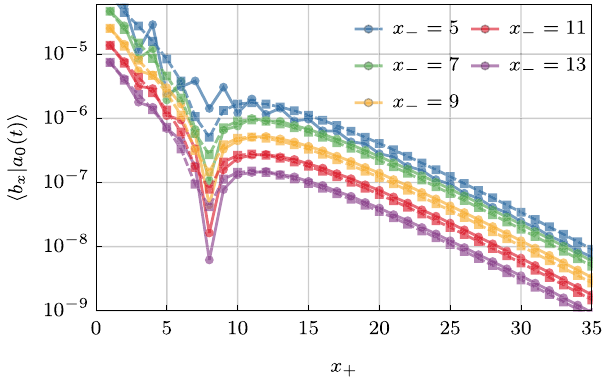
FIG. 10. Relative error for the correlations among σ x operators at integer sites versus x − at large x and small η . The gray line þ reports the upper bound (97). The results are for symmetric generic gate fulfilling Eq. (88), as specified in Table II, with density of defects δ ¼ 1 . The point at x − ¼ 7 has a relative error smaller than 0.3% and is not